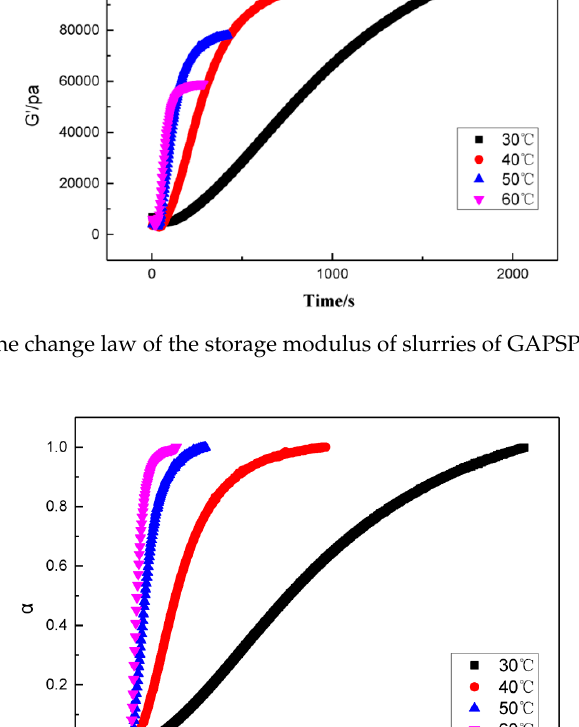
Figure 1. The change law of the storage modulus of slurries of GAPSPs with time.